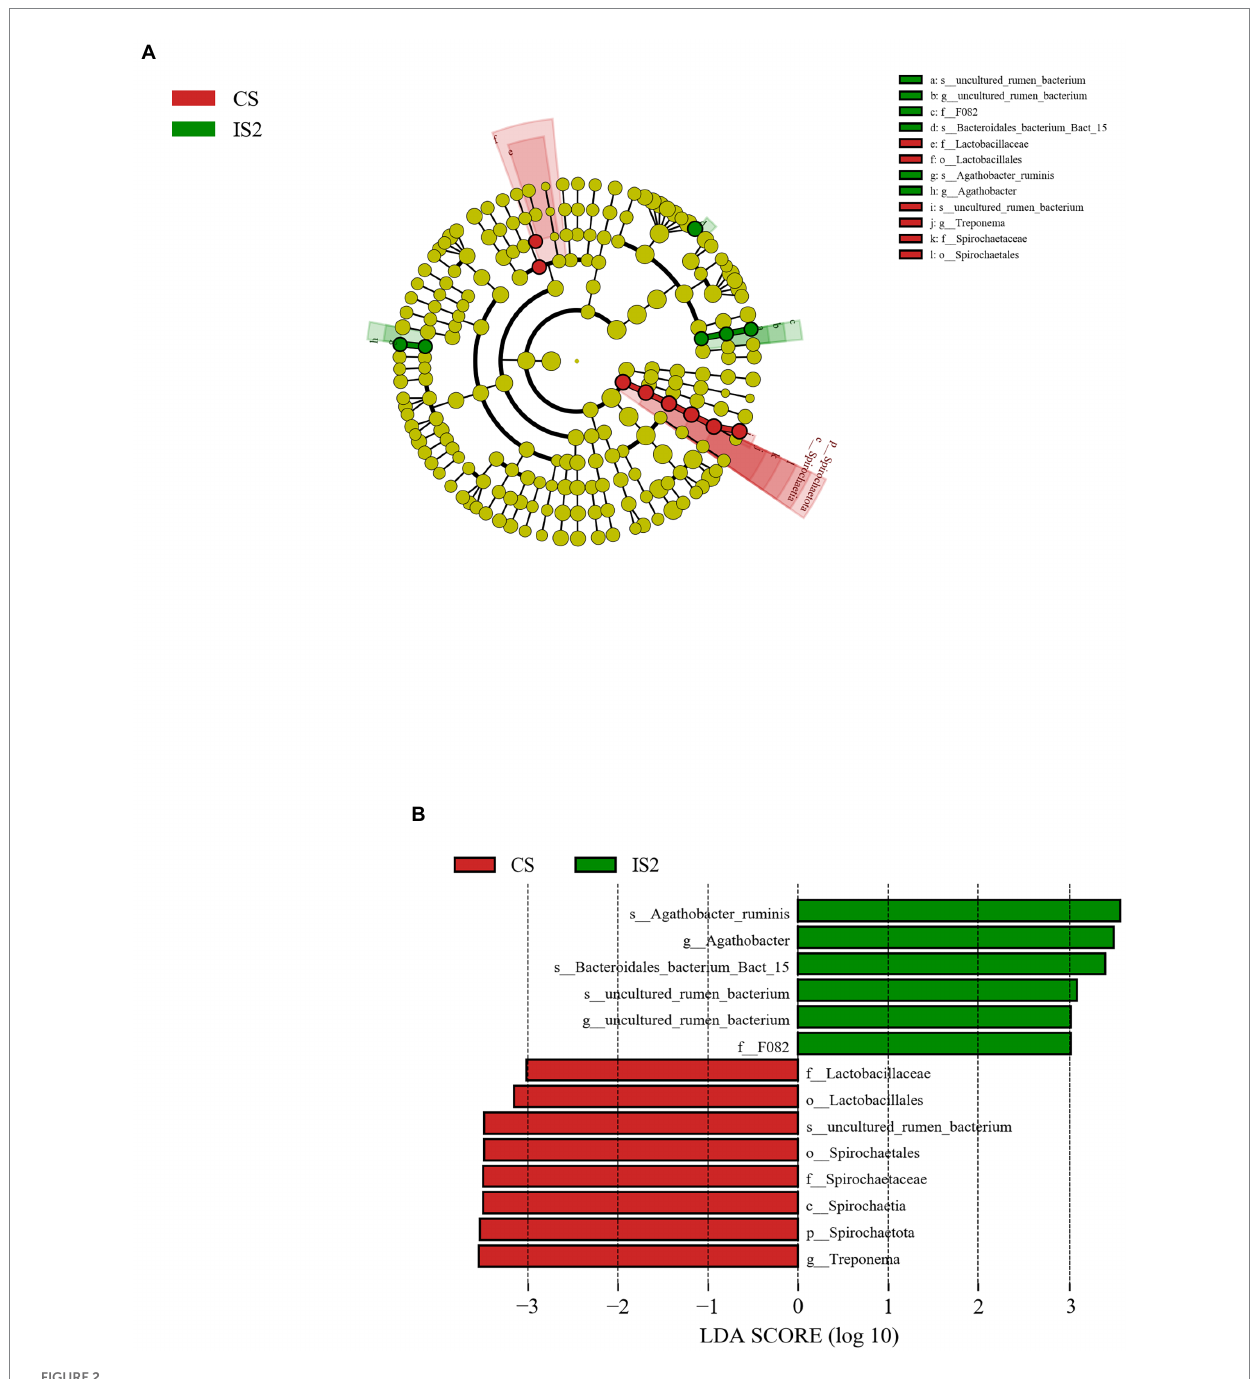
FIGURE 2 The LDA effect size (LEfSe) analysis for the differential bacterial taxa across treatments. (A) Cladogram displays significantly enriched bacterial taxa (from the phylum to the species level). Red: taxa abundant in the CS treatment; Green: taxa abundant in the IS2 treatment. (B) Bar chart displays LDA scores across treatments. The LDA scores represented the difference in relative abundance with exponent fold change of 10 across treatments. Significant differences are defined as P < 0.05 and LDA score >